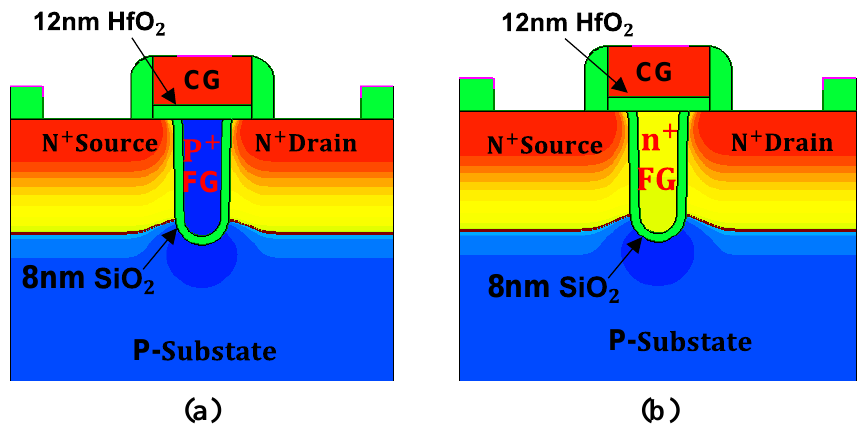
Figure 1. The device structure of ( a ) a new FG memory structure UFGM with p + floating gate (FG) and ( b ) UFGM with n + FG.